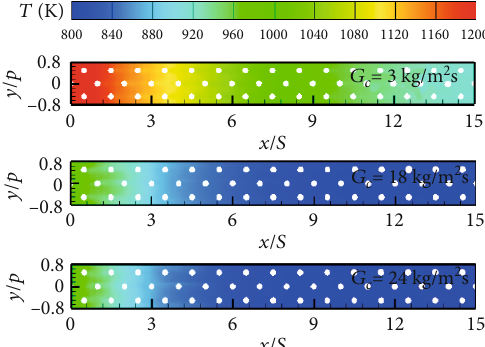
Figure 10: Temperature distribution on the hot-side surface at di ff erent coolant fl ow rates.